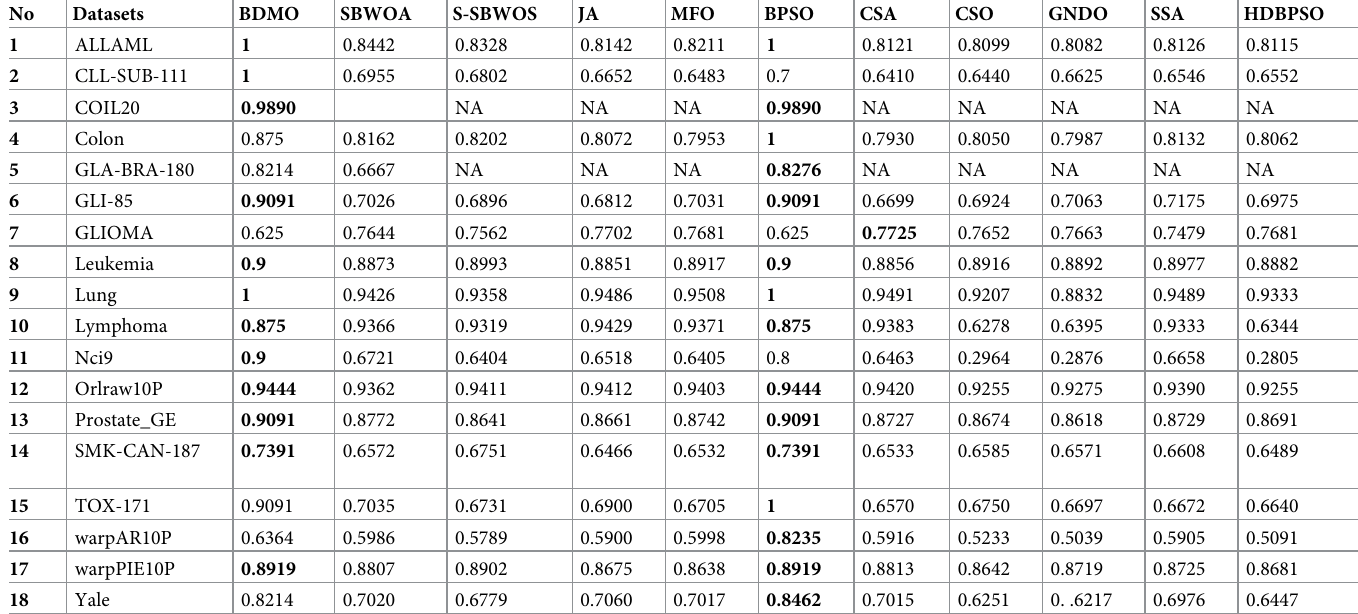
Table 6. Precision of BDMO and other approaches.